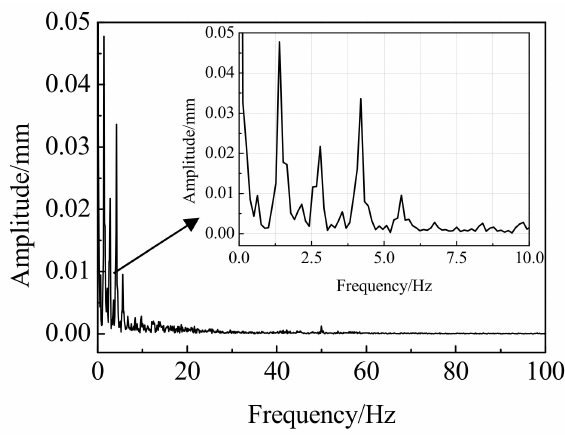
Figure 8. Frequency domain diagram of vertical displacement dynamic response signals.